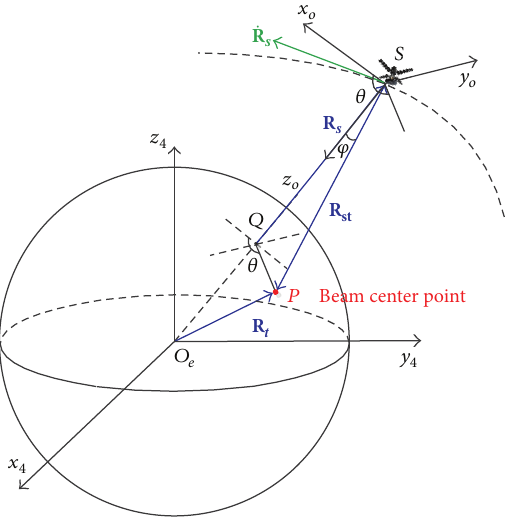
Figure 1: Geometry of the earth rectangular coordinates and satellite local